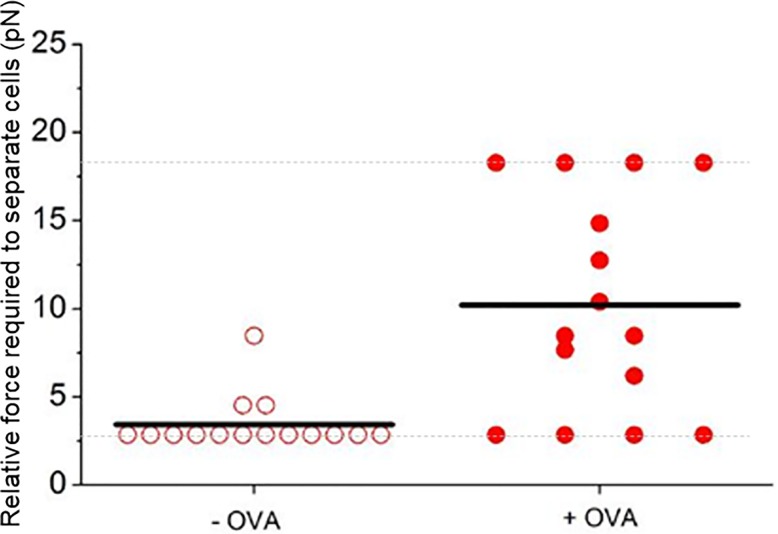
Antigen-specific increase in interaction force between dendritic cells and T-cells.Bone marrow-derived dendritic cells were pulsed with 1 mg/ml OVA (filled symbols) before addition of OVA-specific OT-II T-cells. Control cells remained un-pulsed (empty symbols). The relative force required to separate T-cells and dendritic cells after 30 seconds of interaction was determined for 15 cell pairs using the approach outlined in Fig 2. The black lines represent the median average of the measurements. The dotted grey line the minimum and maximum measurement range. A significant difference in relative interaction force is seen as evidenced by the Mann Whitney test (p ≤ 0.005).